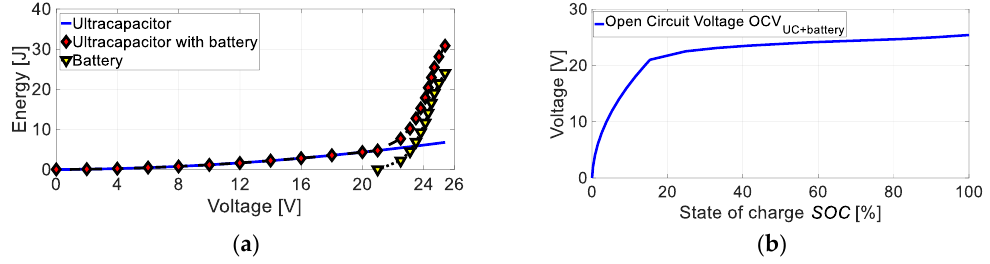
Figure 3. Plot ( a ) — energy stored in: battery, ultracapacitor, and ultracapacitor – battery system as a function of OCV . Plot ( b ) — open circuit voltage as function of state of charge OCV = f ( SOC ) for ultracapacitor – battery system.